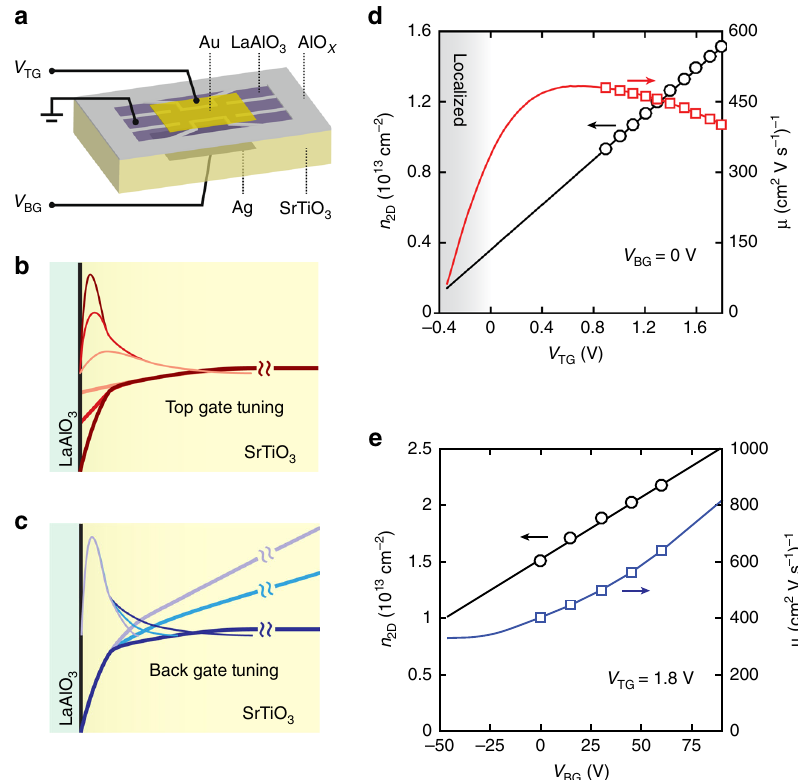
Fig. 1 Operation of the dual-gate device. a The dual-gate device is formed by applying a Au electrode on top of the eight unit-cell epitaxial LaAlO 3 layer and a Ag electrode from the back of the SrTiO 3 substrate with 0.5 mm thickness. The channel width is 400 μ m with Hall bars patterned by predeposited AlO x hard mask. b , c Schematic diagram of the dual-gate operation for top- and back-gates, respectively. The thin lines represent the electron envelope wavefunction perpendicular to the interface at different gate voltages colour-matched to the thick solid lines, which represent the corresponding con fi nement potential. d , e Top- and back-gate modulation of carrier density (circles) and Hall mobility (squares) at T = 600 mK. The straight solid black lines are linear fi ts to the circles. The red and blue curves are estimates of mobility based on the measured sheet resistivity and fi tted extrapolation of Hall density. The ranges of the solid lines correspond to the experimentally accessible tuning